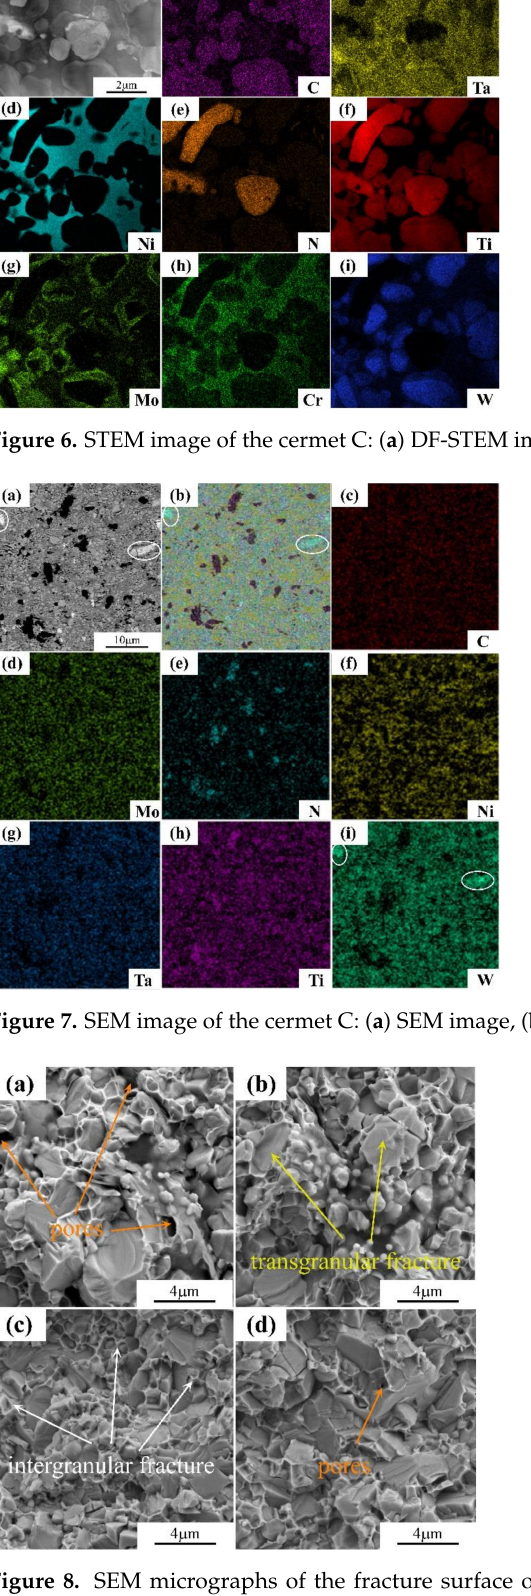
Figure 8. SEM micrographs of the fracture surface of the (Ti,W)C-xTa-based cermet, x in wt.%: ( a ) x = 0, ( b ) x = 1, ( c ) x = 3, and ( d ) x =